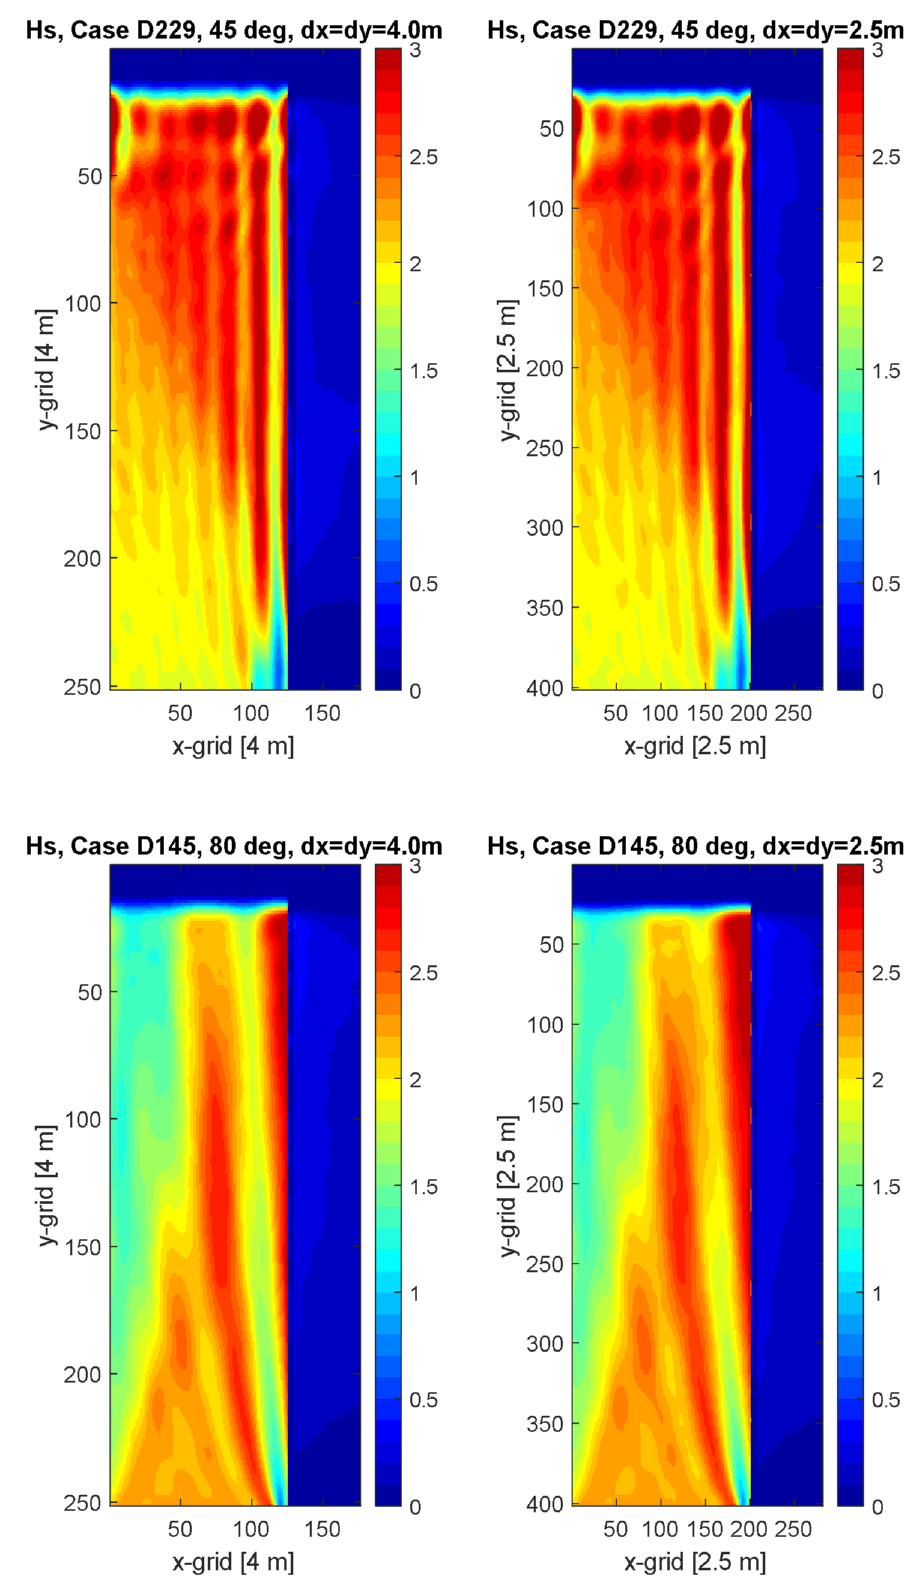
Figure 6. Spatial distribution of significant wave heights with different grid sizes (upper: Case D229, 45 deg, dx = dy = 4.0 m and dx = xy = 2.5 m; lower Case D145, 80 deg, dx = dy = 4.0 m and dx = xy = 2.5 m).